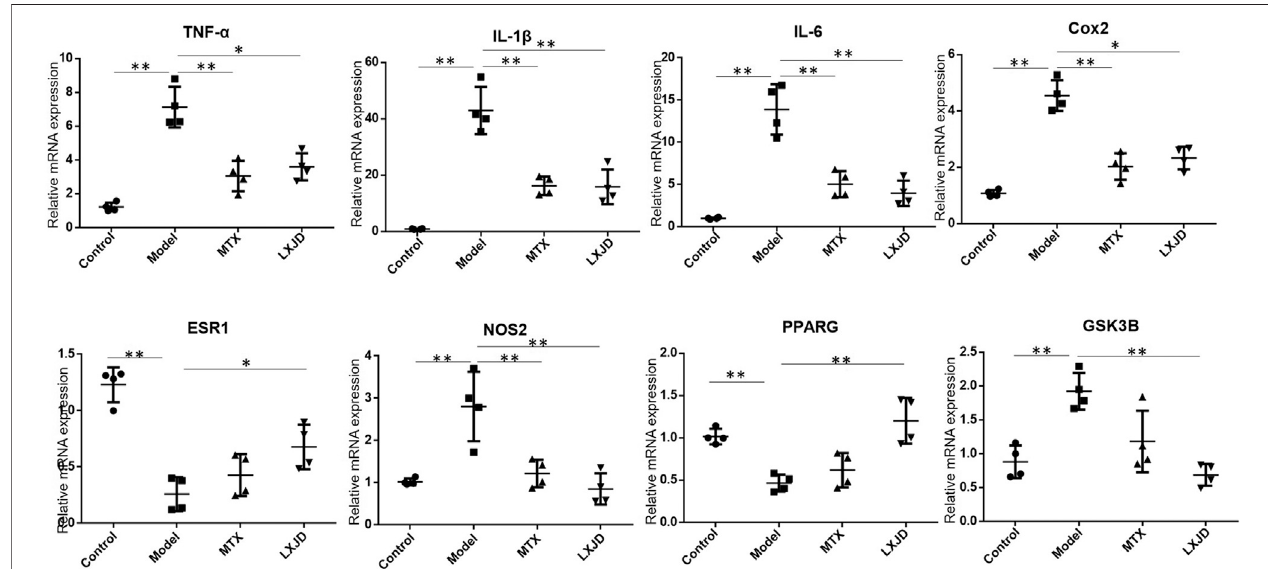
FIGURE6| ThemRNAexpression ofkeyin fl ammatorycytokinesandpredictedgenesintheskinlesionofthepsoriasis-likemousemodel.Valueswerenormalized to β -actin and expressed relative to the control group. Data are shown as mean ± SD. n (cid:2) 4 mice. * p < 0.05 and ** p < 0.01 vs. model group.